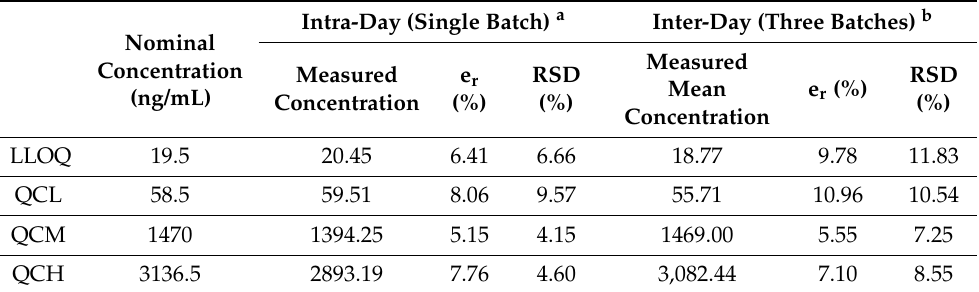
Table 4. Intra- and inter-day precision and accuracy of the HPLC-FLD method used for the determi- nation of the capmatinib levels in rat plasma.